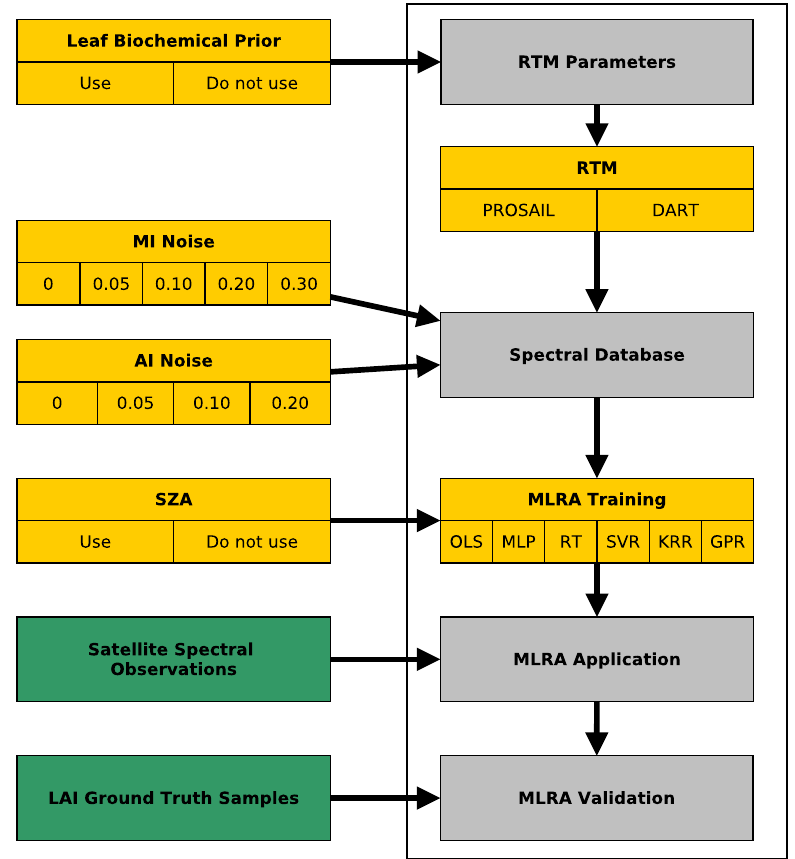
Figure 4. Flowchart of the applied workflow. Varied feature domains have orange background, LAI ground truth green background. For abbreviations, the reader is referred to the